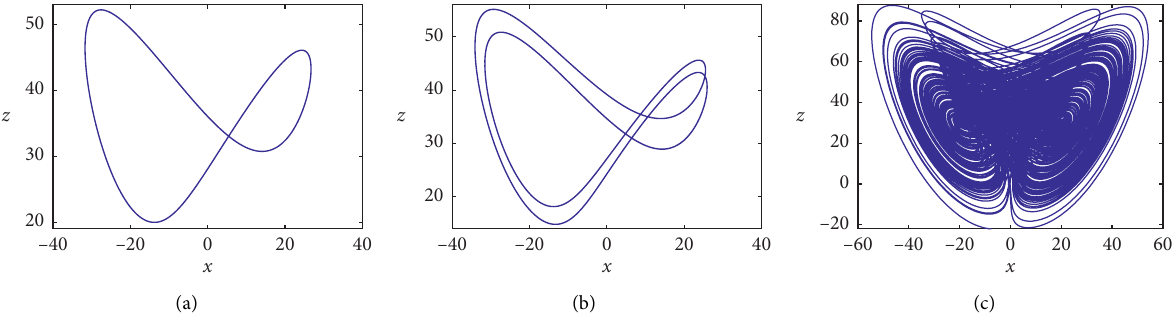
Figure 10: Influence of parameter c on the attractors of the x-z plane: (a) c � 29, period-1, (b) c � 28.1, period-2, and (c) c � 24.4, chaotic state. Table 3: Correlation values of different sequences under tiny different initial values.